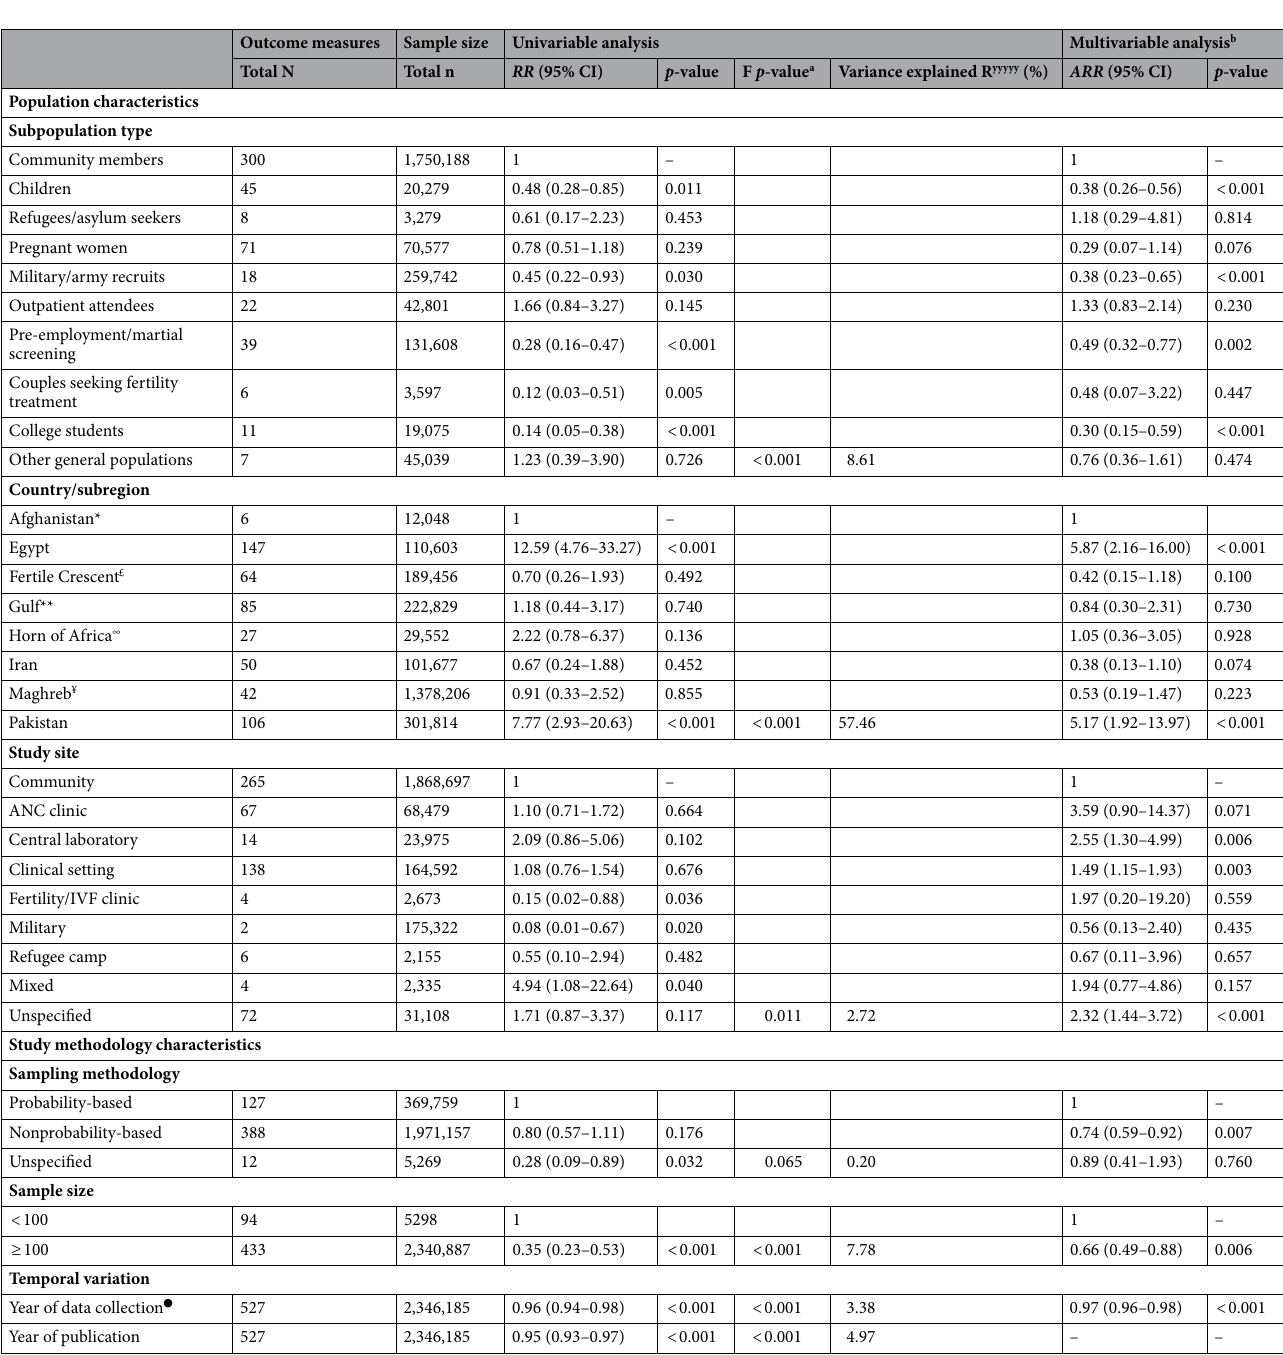
Table 5. Univariable and multivariable meta-regression analyses for HCV Ab prevalence in the general population, but excluding blood donors, in the Middle East and North Africa. Abbreviations: Ab, antibody; ANC, antenatal care; ARR, adjusted relative risk; CI, confidence interval; HCV, hepatitis C virus; IVF, in vitro fertilization; RR, relative risk. *Afghanistan was chosen as a reference country given the availability of considerable number of studies in the general population, low HCV prevalence in the general population, and being the first country alphabetically to qualify accordingly. £ Countries include Iraq, Jordan, Lebanon, Palestine, and Syria. **Countries include Bahrain, Kuwait, Oman, Qatar, Saudi Arabia, and United Arab Emirates. ∞ Countries include Djibouti, Somalia, Sudan, and Yemen. ¥ Countries include Algeria, Libya, Mauritania, Morocco, and Tunisia. ● Due to collinearity between year of data collection and year of publication, the multivariable analysis included only one of these variables, year of data collection. a Variables with a p-value ≤ 0.2 were eligible for inclusion in the multivariable analysis. b The adjusted R-squared for the full model was